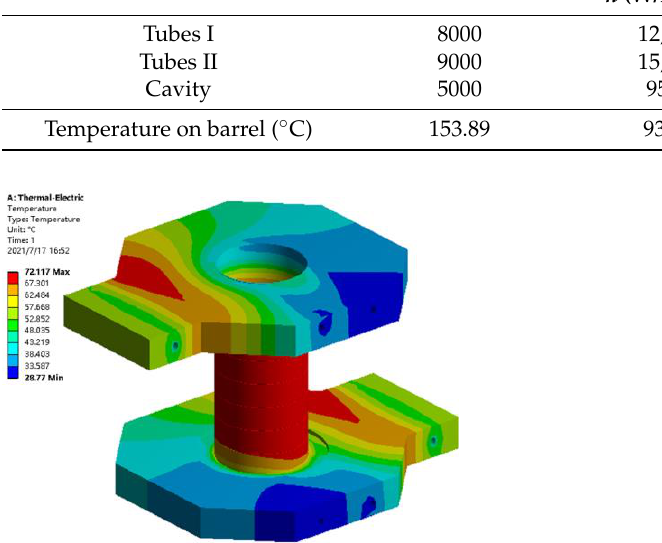
Table 2. The simulated thermal performance of the model under different sets of convective heat transfer coefficients.